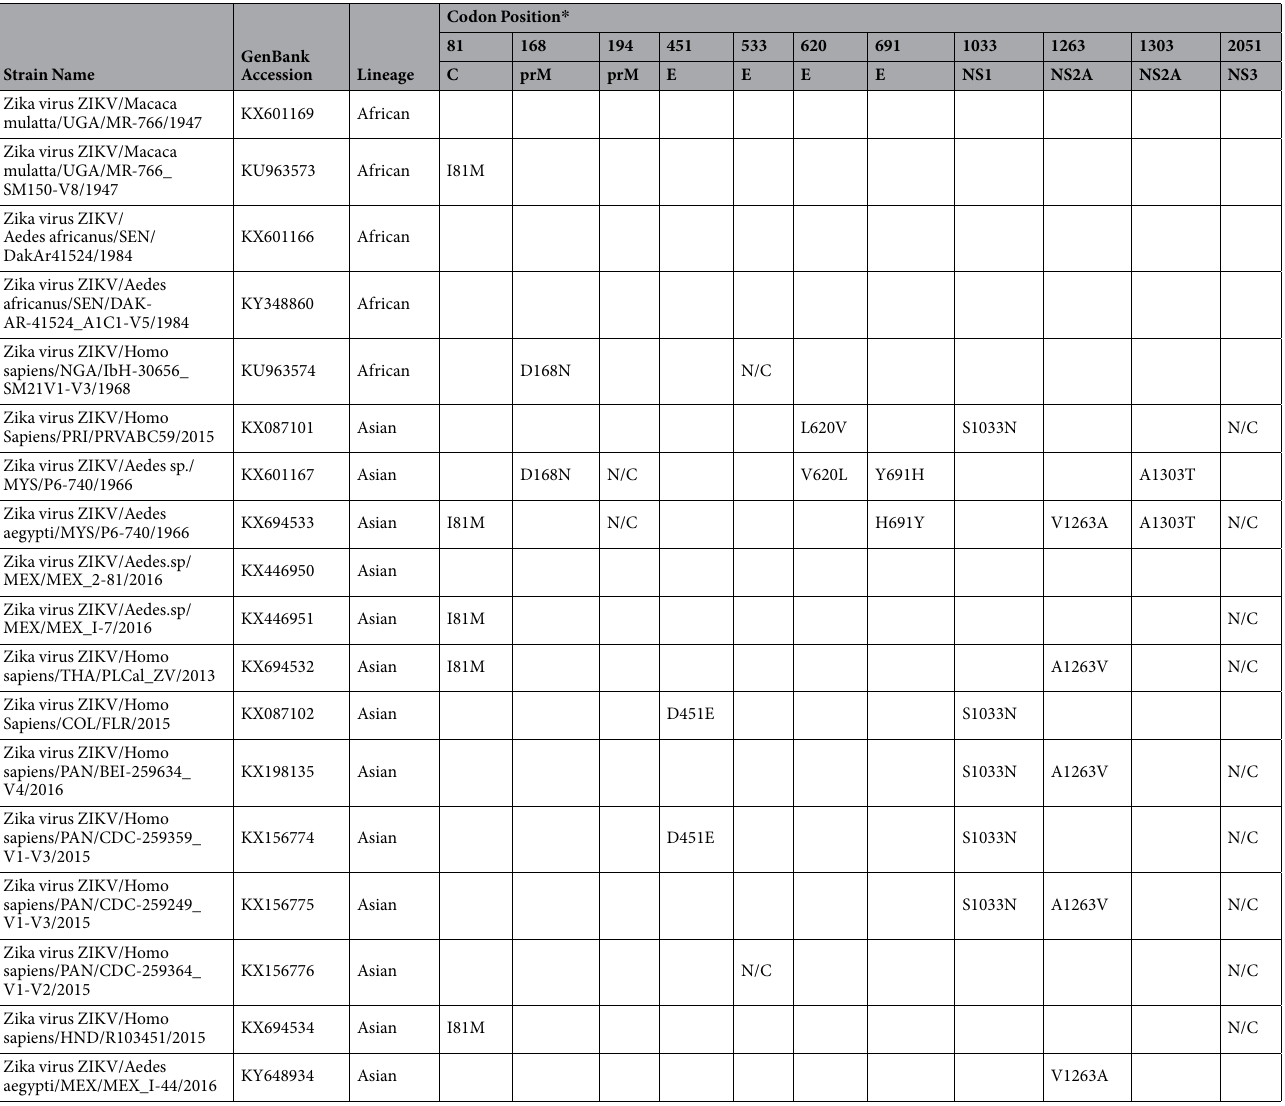
Table 5. Minor variants ( > 20%) observed in codons across Asian and African lineages and the effect on amino acid residue. * Positions are codon numbers in the polyprotein with genes indicated inside the parentheses. N/C = No change in amino acid